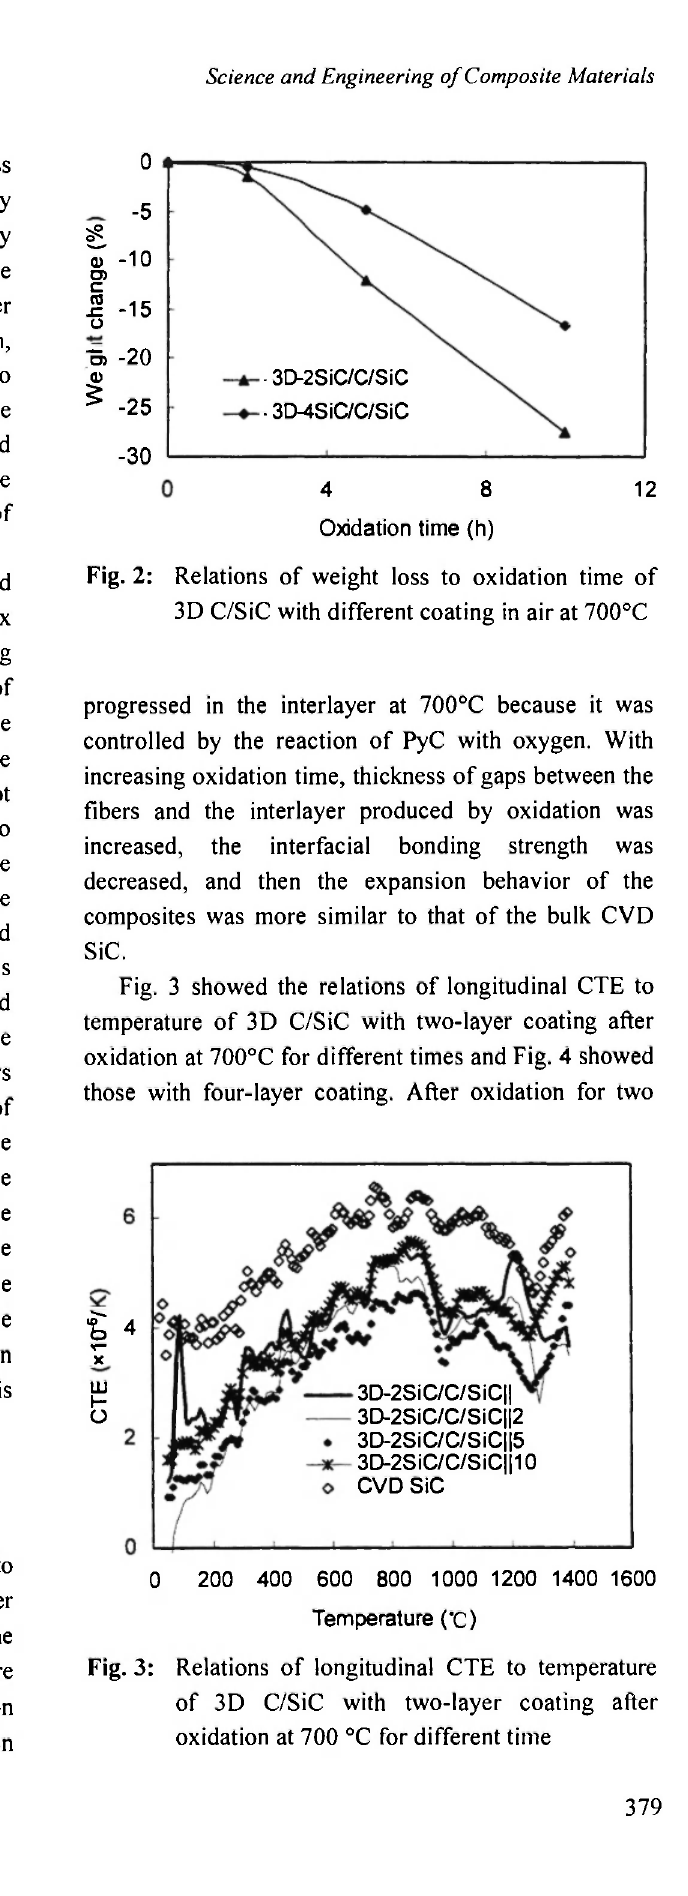
Fig. 3: Relations of longitudinal CTE to temperature of 3D C/SiC with two-layer coating